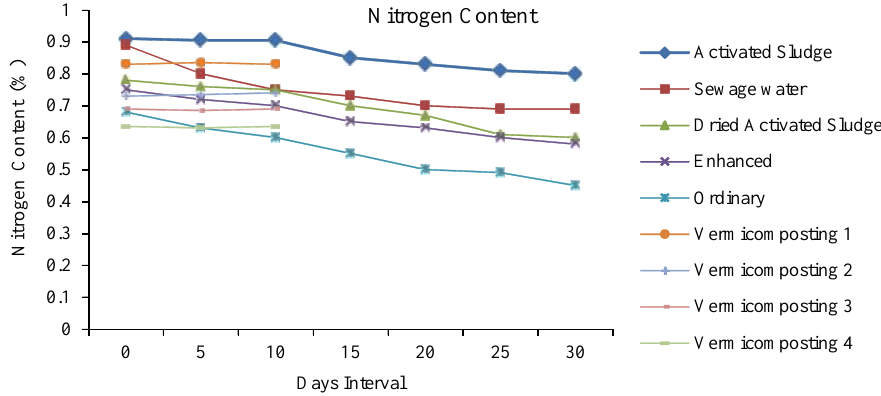
Fig. 2: Comparison of nitrogen levels in compost